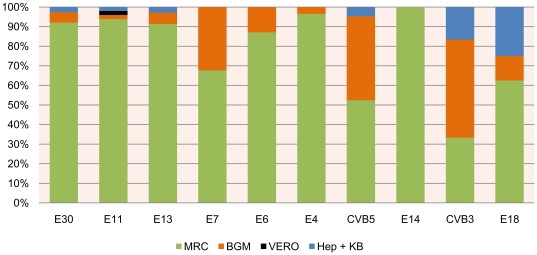
Isolation of the 10 most common Enterovirus serotypes by cell line.MRC5 cells were the most conducive culture line for 84.9% of the samples, with the addition of BGM cell lines enhancing total sample recovery up to 96.3% and covering all serotypes.